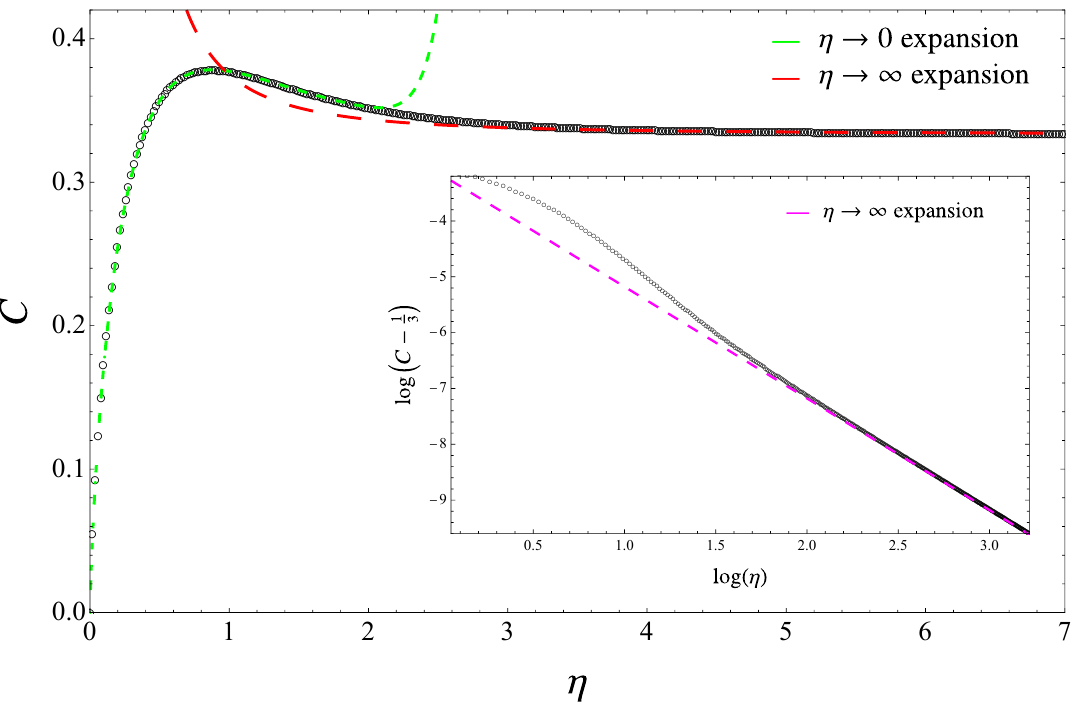
Figure 5. The quantity C defined in (5.10): the data points have been obtained from (5.12), while the dashed lines correspond to the small and large interval expansions, found from (7.4) and (5.17) respectively. The inset focuses on the large interval regime in logarithmic scale and the straight dashed magenta line corresponds to